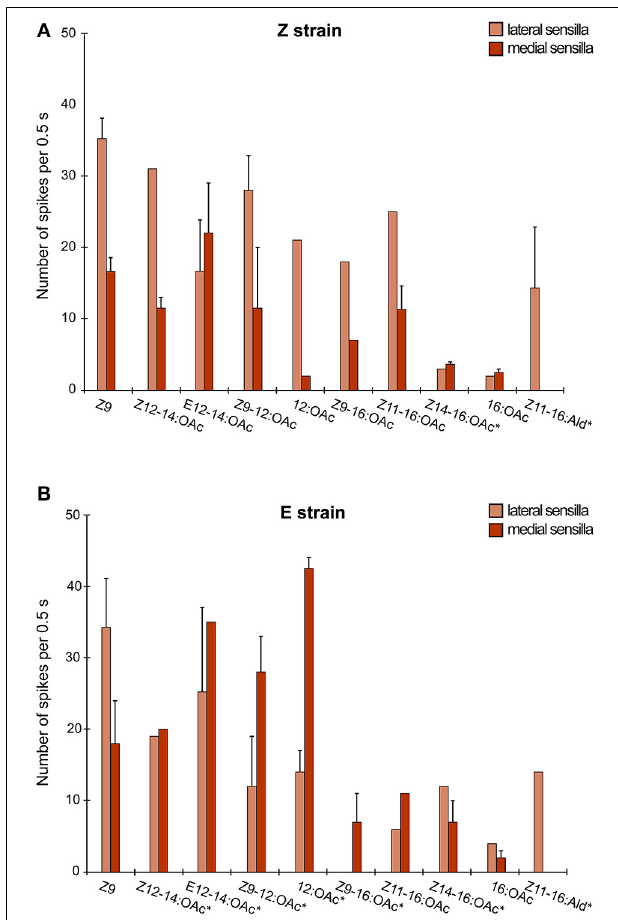
FIGURE 5 | The response of the behavioral antagonist neuron to 10 pheromone compounds, in the Z-strain (A) and the E-strain (B). Medial (dark brown) and lateral (light brown) sensilla differed in their response. Also, the response of this neuron was mosaic: not all neurons uniformly responded to all compounds in the test panel. A percentage on each bar demarcates the fraction of the tested neurons that responded to the compound. Compounds were tested at 1 µ g dose on filter paper. A ∗ in the x-axis labels indicates that this compound was tested at 10 µ g.